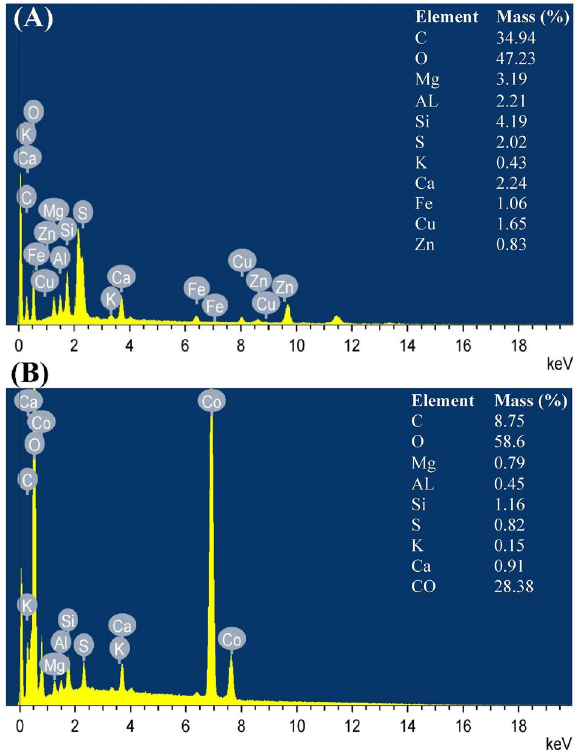
Figure 8. EDS, illustrated Enteromorpha intestinalis biomass: ( A ) before and ( B ) after Congo red and Co 2+